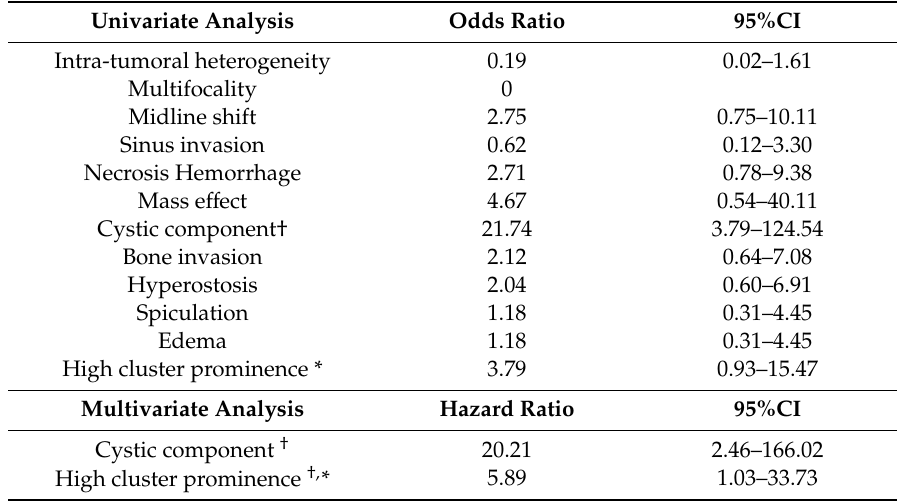
Table 2. Univariate and multivariate analysis of semantic characteristics and selected radiomic feature (cluster prominence) for tumor recurrence.